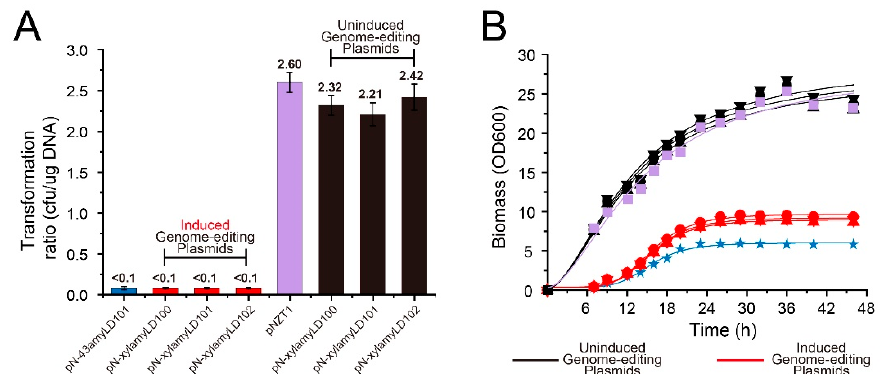
Figure 2. Transformation ratio of the different constructs ( A ). The genome-editing plasmids pN-xylamyLD100, pN-xylamyLD101, and pN-xylamyLD102 were used to transform B. licheniformis under induced and uninduced conditions. pN-43amyLD101 and pNZT1 were used as the control sets. Transformation efficiency was calculated as the number of transformants per μ g of plasmid DNA. Growth of the recombinant strains ( B ). ■ BLG100, ● BLG109-uninduced, ▼ BLG108-uninduced, ▲ BLG107-uninduced, ★ BLG110, ● BLG109-induced, ▼ BLG108-induced, and ▲ BLG107-induced. BLG100, BLG110, BLG107-uninduced, BLG108-uninduced, and BLG109-uninduced cells were cultured in standard medium, while BLG107-induced, BLG108-induced, and BLG109-induced cells were cultured in medium containing 0.5% xylose. Then, 250-mL shaking flasks with baffles containing 25 mL of medium were inoculated with specific strains. Biomass was monitored by measuring the absorbance at 600 nm (OD600). The cell culture samples were diluted to suitable concentrations before detection to maintain the absorption reading range of the spectrophotometer between 0.2 and 1.2. The results are expressed as the mean of three replicates ( n = 3).